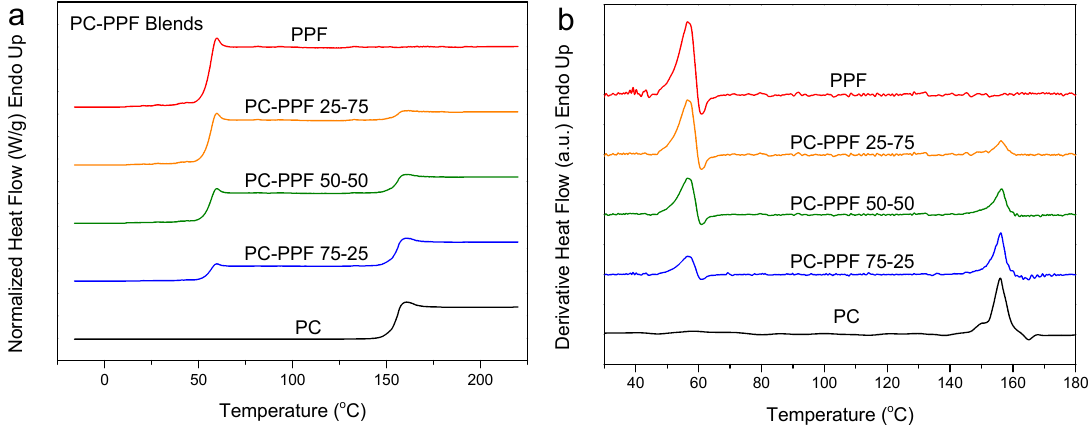
Figure 10. ( a ) DSC heating thermograms, and ( b ) derivative heat flow for melt-quenched PC–PPF blend samples.